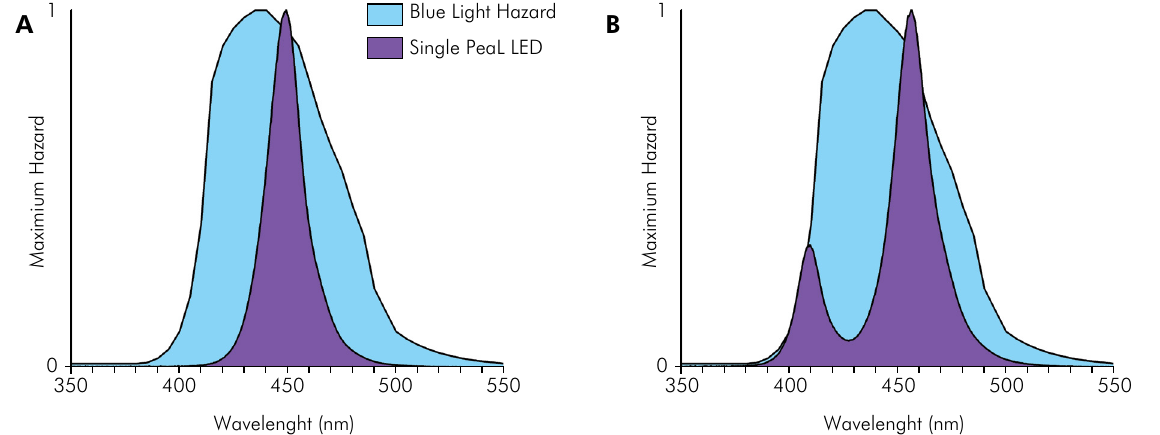
Figure 38. Maximum hazard versus wavelength (nm) graph for single peak (A) and broadband LED light-curing